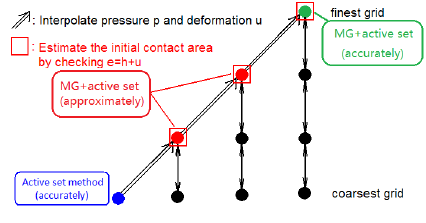
Figure 4. The FMG